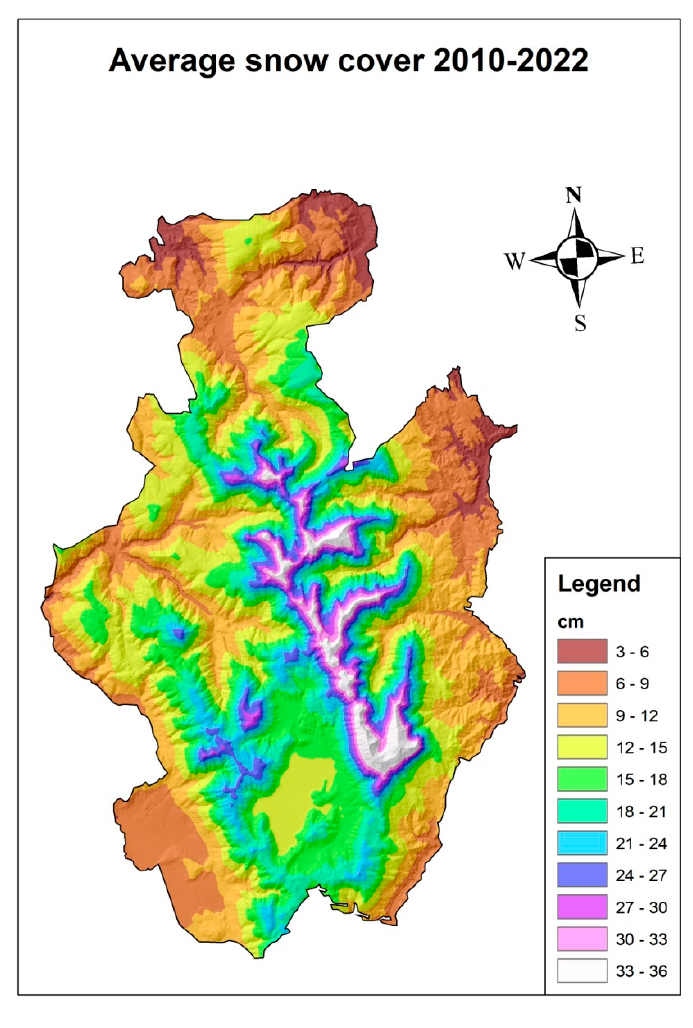
Figure 6. Average snow depth in the period 2010–2022 measured in cm.